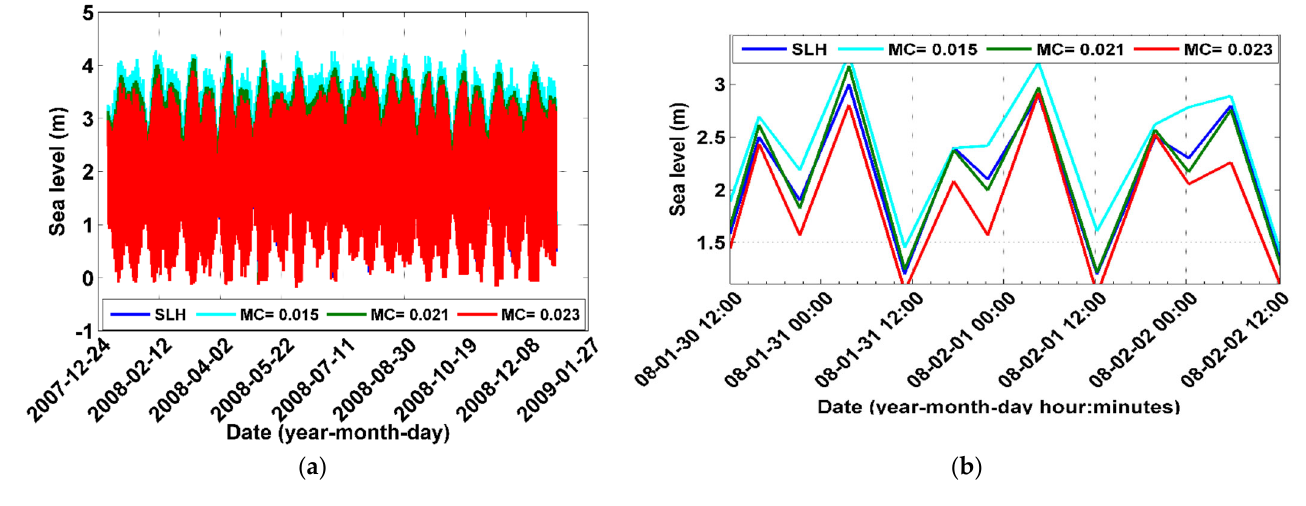
Figure 10. ( a ) Performances of Manning coefficients (MCs) of 0.015, 0.021, and 0.023 at Rajaei control station and their effects on SLH; ( b ) separated portion of ( a ) to show more details.